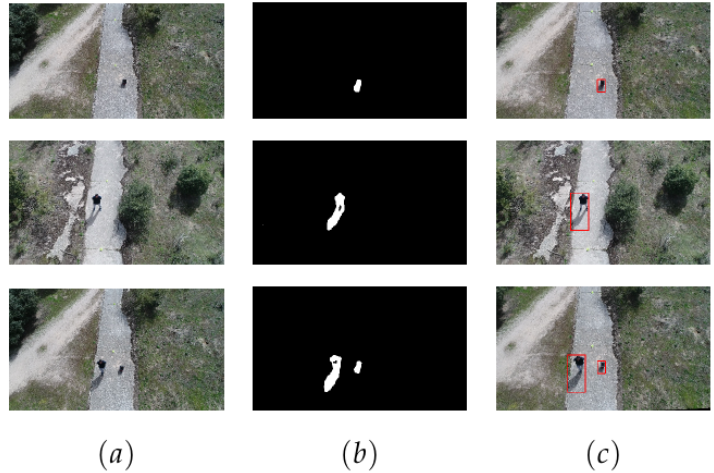
Figure 9. Results of our system applied to images acquired from an unmanned aerial vehicle (UAV), not included in the dataset. In this case, column ( a ) represents the foreground image, column ( b ) the binary image predicted and column ( c ) the original image bounding boxes as in previous